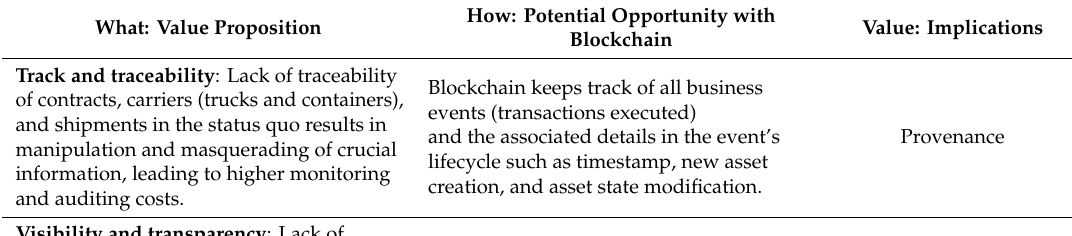
Table 6. Implications of blockchain-based PCS business models, developed by the author based on the St. Gallen conceptual model